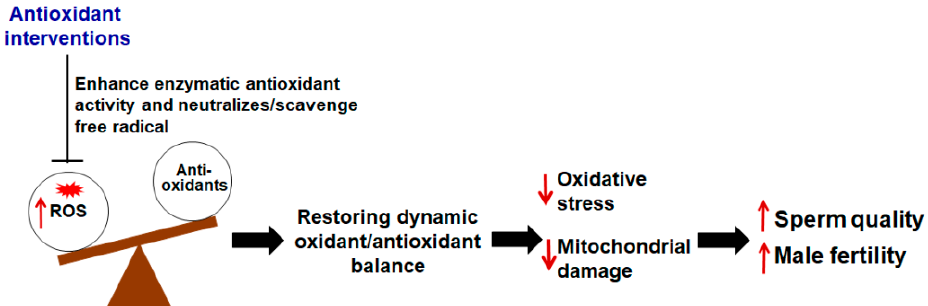
Figure 5. Value of antioxidants in the treatment of male infertility. Antioxidants are ROS “scavengers” which help maintain the body’s oxidant/antioxidant balance. Antioxidative interventions can counteract oxidative damage or OS and reduce mitochondrial damage, thereby improving sperm quality and male